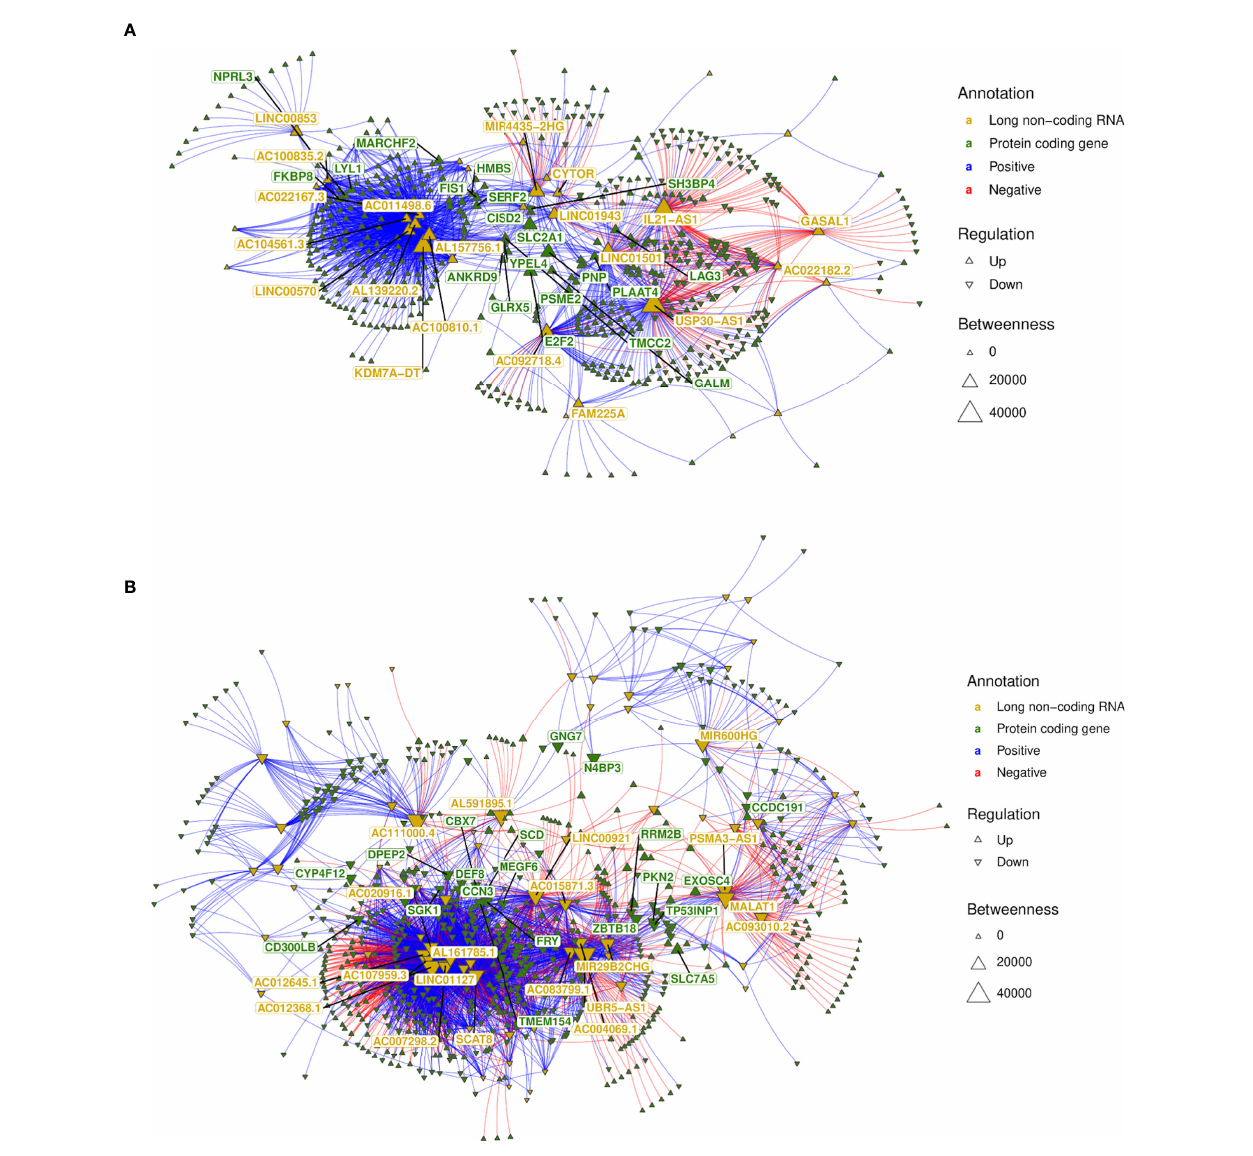
FIGURE 7 | lncRNA – mRNA coexpression network analysis. (A) A network was built with all highly correlated lncRNA – mRNA pairs (1,870 pairs; Supplementary Table 6 ) obtained for 58 lncRNAs downregulated in non-diseased groups (i.e., upregulated in VL patients — PD0); (B) A network was built with all highly correlated lncRNA – mRNA pairs (4,256 pairs; Supplementary Table 6 ) obtained for 89 lncRNAs upregulated in nondiseased groups (i.e., downregulated in VL patients — PD0). The top 20 hubs for lncRNAs and mRNAs are fl agged with gene symbols in yellow and green,